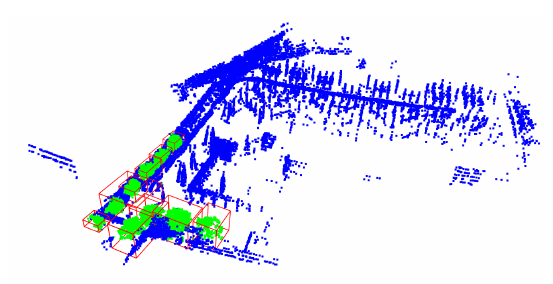
Figure 17. The detection results with training data without ground plane. The detection results of tree5 is more